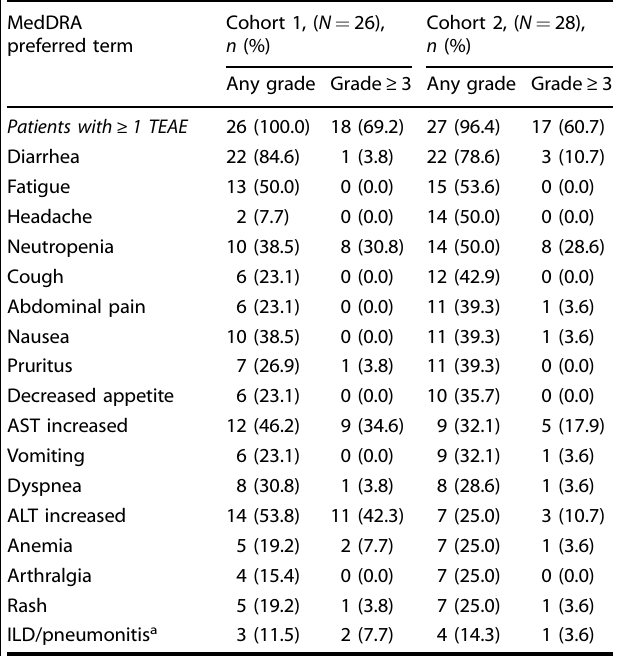
Table 4. Treatment-emergent adverse events (all-causality) occurring in ≥ 25% of patients who received ≥ 1 dose of study treatment (in either cohort, any